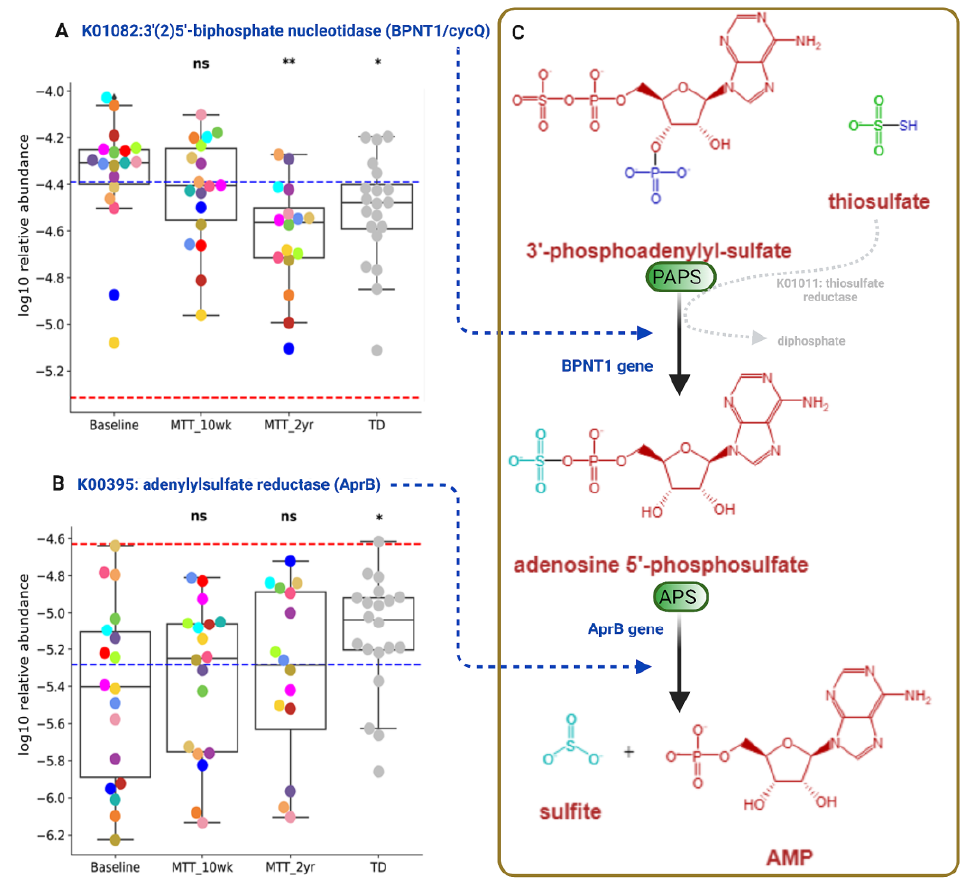
Figure 8. Univariate comparison of the relative abundance (after log 10 transformation) of genes encoding for enzymes involving microbial sulfur metabolism (dissimilatory sulfate reduction) before and after MTT in ASD in comparison with TD. ( A ) K01082 ( BPNT1/cycQ ) 3′(2), 5′ -bisphosphate nucleotidase, ( B ) K00395 ( aprB ) adenylylsulfate reductase, subunit B. ( C ) Diagram Illustrating dis- similatory sulfur reduction and the contribution of BPNT1 and aprB to the process. Each colored dot represents an ASD individual and grey-colored dots represent TD. Red-dashed lines represent the mean of maintenance ( n = 2) and blue represents the median of major donors ( n = 5). Asterisks rep- resent significant differences between ASD Baseline and the other groups (* single asterisk indicates p < 0.05; ** double asterisks indicate p < 0.01; ns: not significant; all p -values are FDR-corrected). ASD: autism spectrum disorder; TD: typically developing.